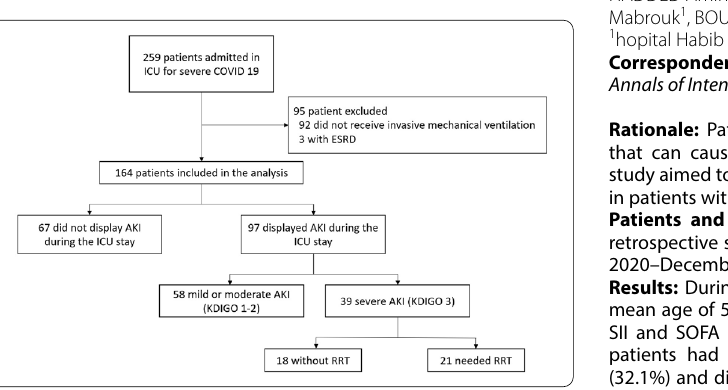
Figure 1: Flow chart of the study AKI: Acute Kidney Injury, ESRD: End-stage renal disease, ICU: Intensive Care Unit, RRT: Renal replacement therapy FC‑021 Is hyponatremia associated with poor outcome in critically ill COVID‑19 patients? SDIRI Ines 1 , JARR AYA Fatma 1 , RACHDI Emna 1 , JAMOUSSI Amira 1 , AYED Samia 1 , BEN KHELIL Jalila